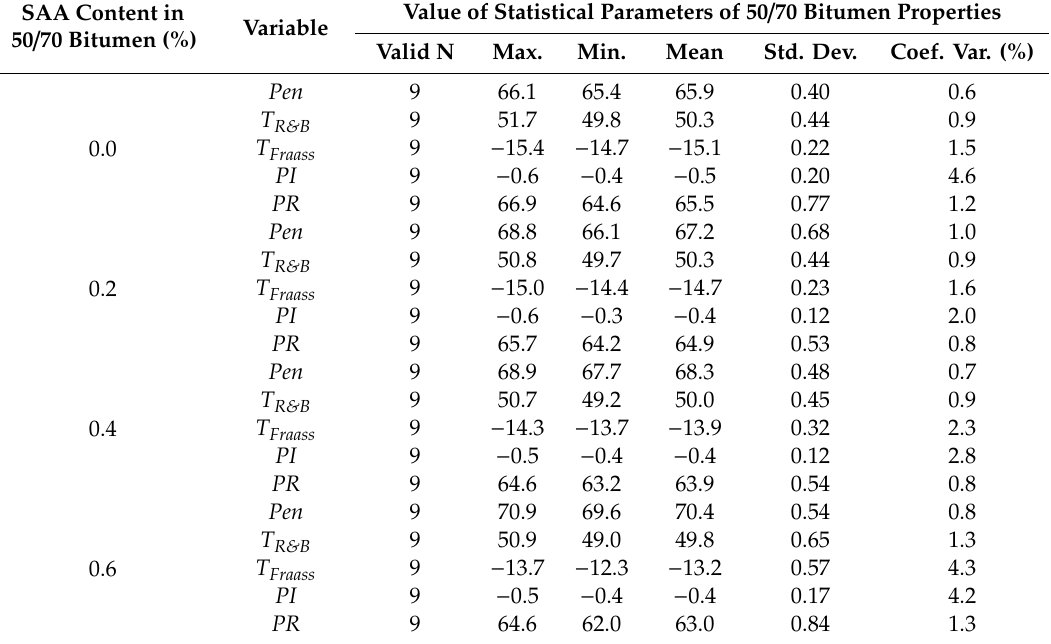
Table 4. Statistical values of 50 / 70 bitumen properties versus SAA content.